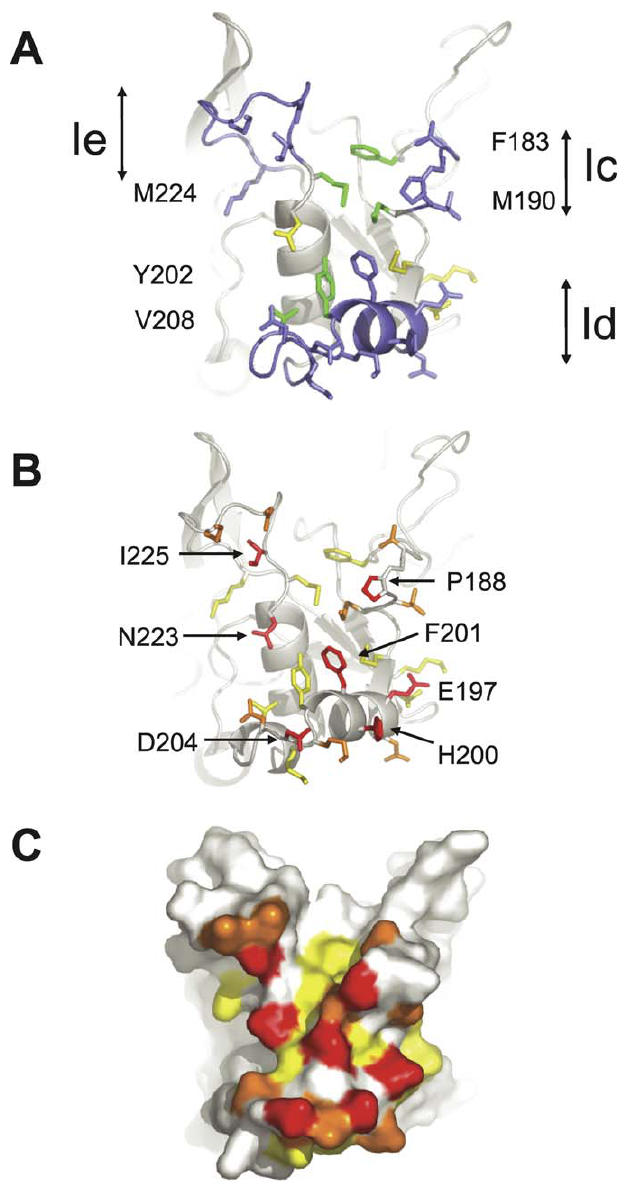
(A,B) Show identical views of the epitope with side chains that interact with AMA1 with a buried surface area of 7 A˚ 2 or more shown in stick form. (C) Is the same view but showing the surface of the epitope. (A) Hydrophobic trough residues that contact 1F9 are shown in green with their residue numbers on either side of the figure. Loops Ic, Id, and Ie and their 1F9-contacting residues are shown in blue. Side chains that extend from the PAN domain scaffold and interact with 1F9 are coloured yellow. (B,C) Principal contact residues. Side chains contacting 1F9 with a surface area of greater than 78 A˚ 2 or more are coloured red. Side chains with a contact surface area of between 68 and 38 A˚ 2 are coloured orange. Side chains with a contact surface area of between 24 and 7 A˚ 2 are coloured yellow. Surface area interactions were calculated using AREAIMOL